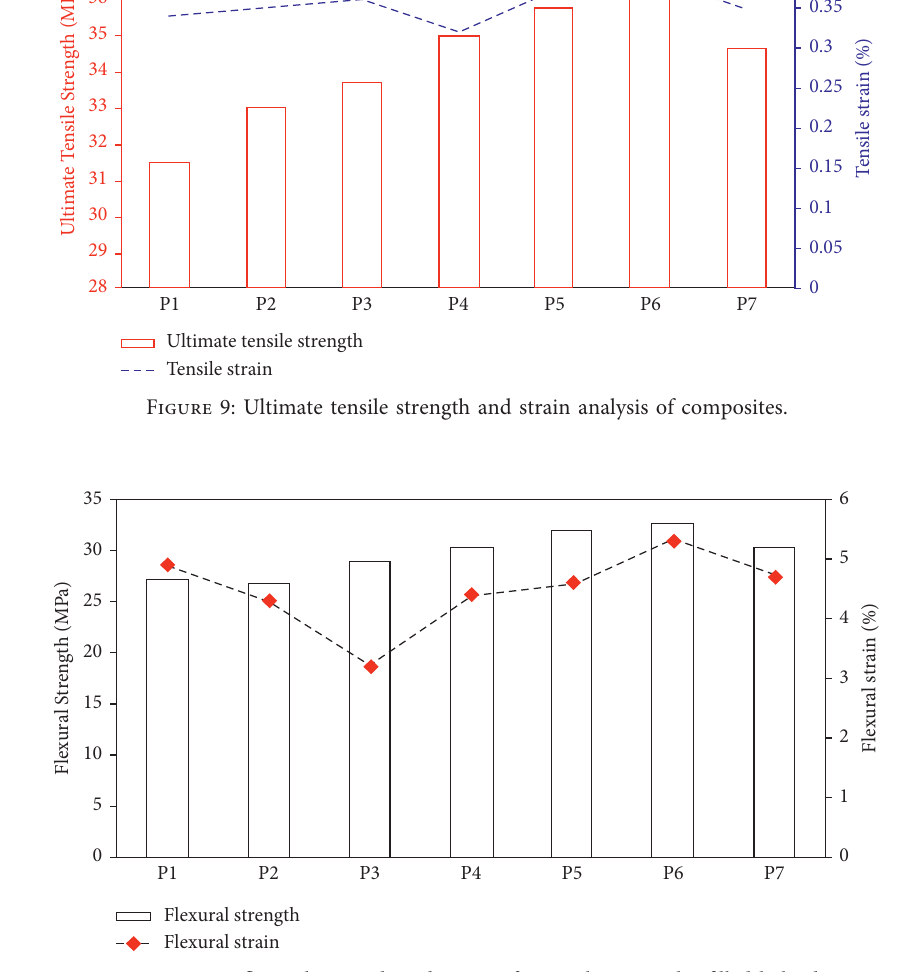
Figure 10: Variations on flexural strength and strain of nanosilica particles filled hybrid